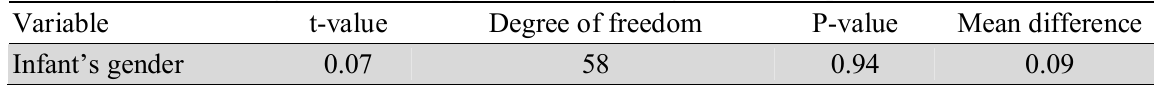
The results of surveying the relationship between infant’s gender and depression Variable